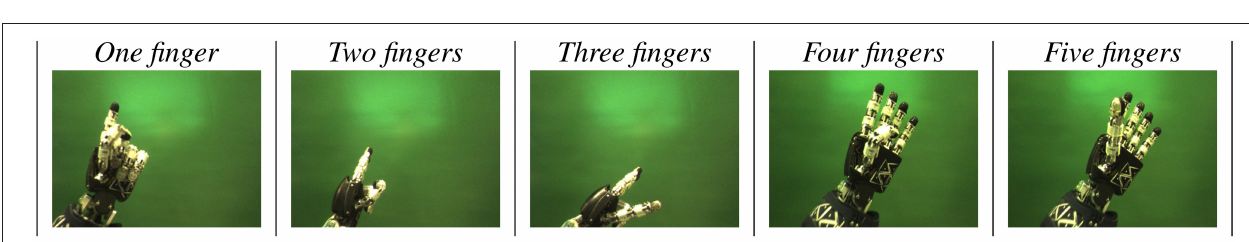
FIGURE 5 | Examples of from the subset of test images that are correctly classified by all networks.